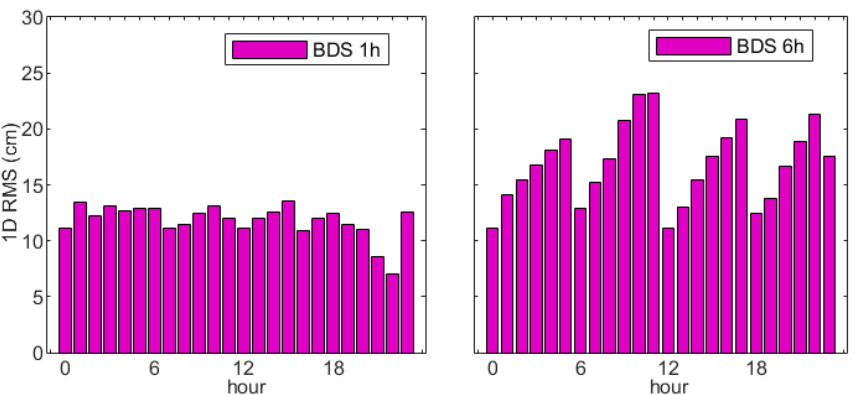
Figure 10. Accuracy of BDS ultra-rapid predicted orbit updated per 6 h and BDS ultra-rapid pre- dicted orbit updated per 1 h. orbit updated per 1 h.